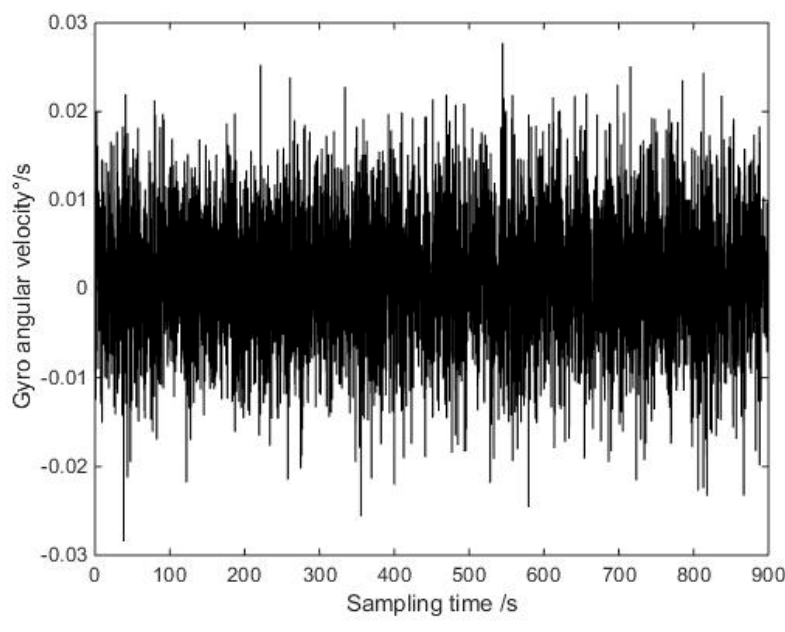
Figure 10. Drift error compensation.